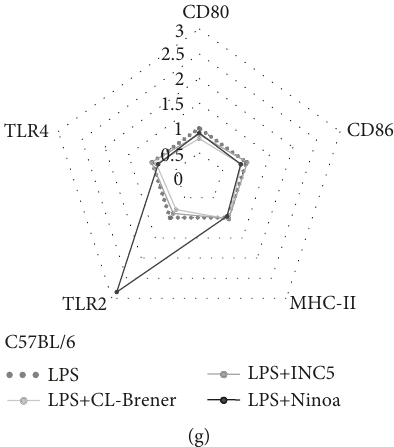
Figure 6: Expression of MHC-II, costimulatory molecules, and toll-like receptors in BMDCs after in vitro T. cruzi infection. The expression of molecules was evaluated by fl ow cytometry and represented as a variation of the mean intensity of fl uorescence (a) MHC-II, (b) CD80, (c) CD86, (d) TLR2, and (e) TLR4. (f, g) Representation of the cytokine secretion pattern in BMDC culture supernatant. The lines highlight the change in cytokine levels in LPS-stimulated BMDCs and infected with di ff erent strains of T. cruzi (MOI 2 :1) in relation to uninfected LPS-stimulated BMDCs. Statistical analysis, when applicable, was performed with the Kruskal-Wallis test with Dunn ’ s posttest, where ∗ p < 0 05